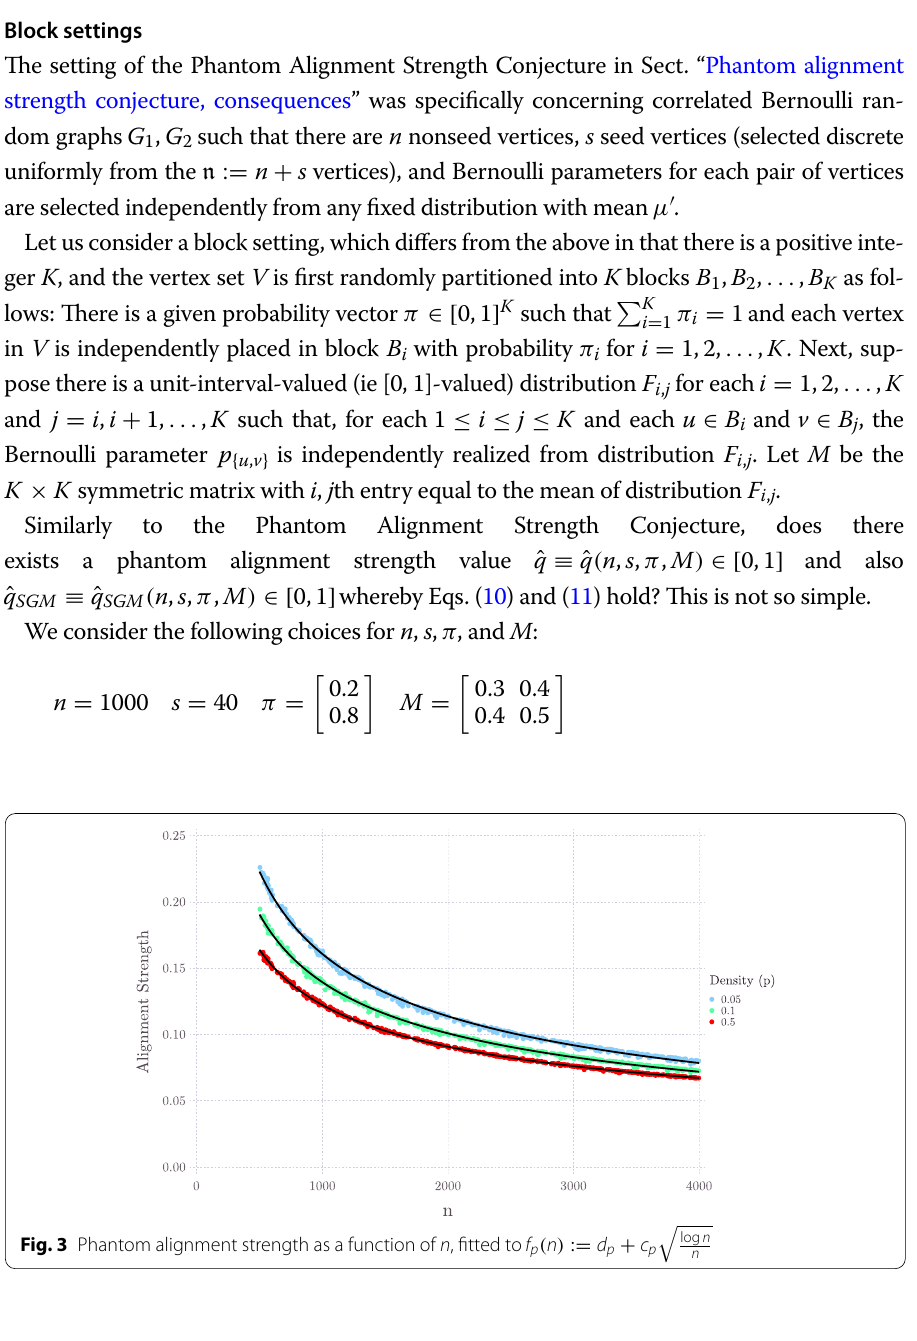
Table 1 Values of the constants in f p ( n ) := d p + c p p d p c